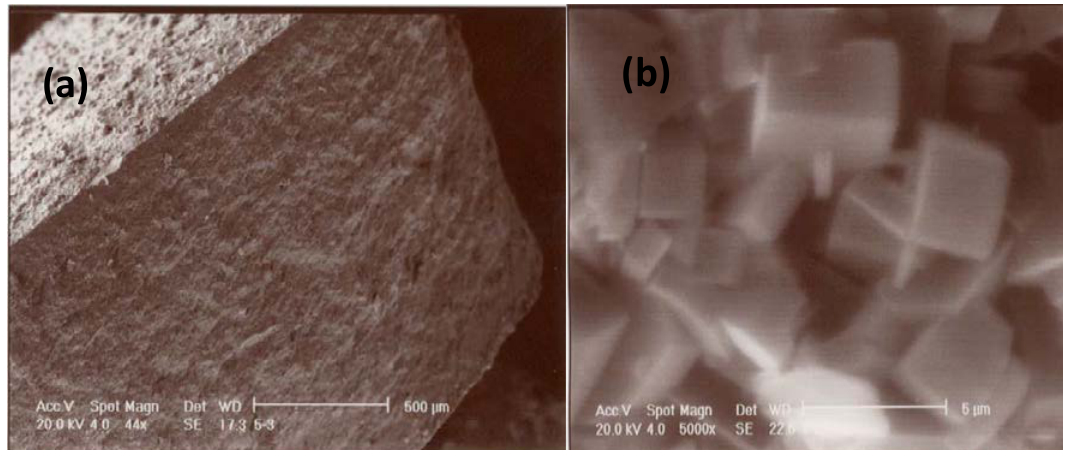
Fig. 7: SEM of the ZSM-5 zeolite membrane; (a) surface and (b) cross section